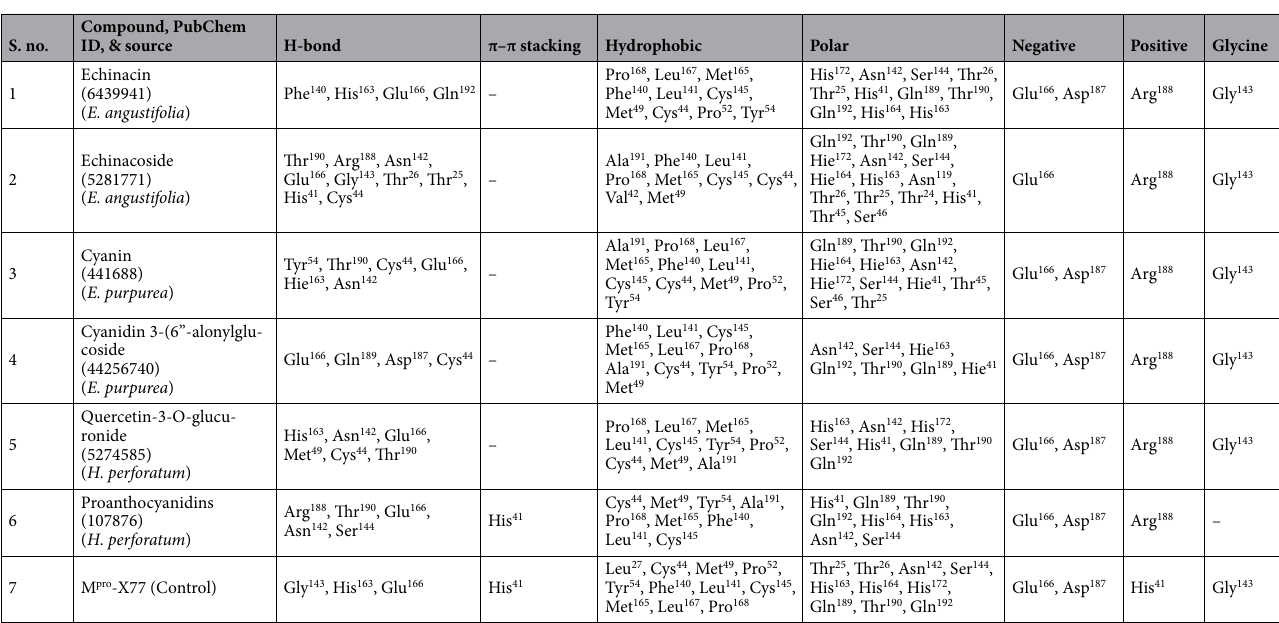
Table 1. Molecular interaction analysis of SARS-CoV-2 M pro with screened phytochemicals from selected